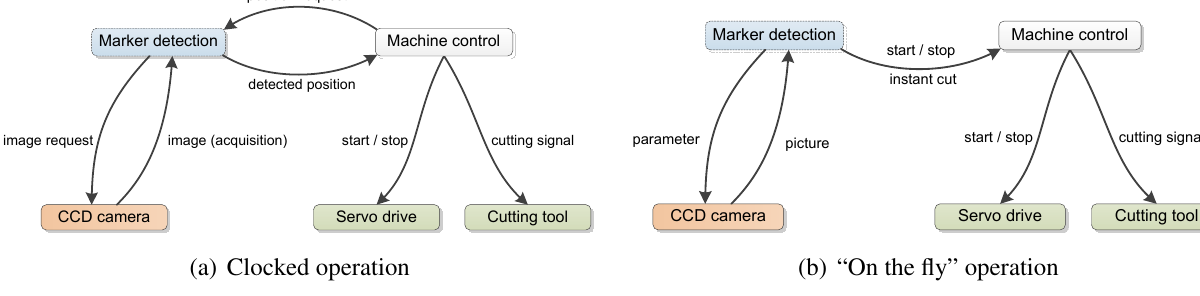
Figure 5. Interaction of the sensor (red) and actuators (green) in terms of two controlling strategies of the picking system: ( a ) clocked and ( b ) “on the fly” mode of operation. Figure 8 depicts the details of the “marker detection” module (dashed) which are presented throughout this paper. It serves as the (algorithmic) interface between the sensor and